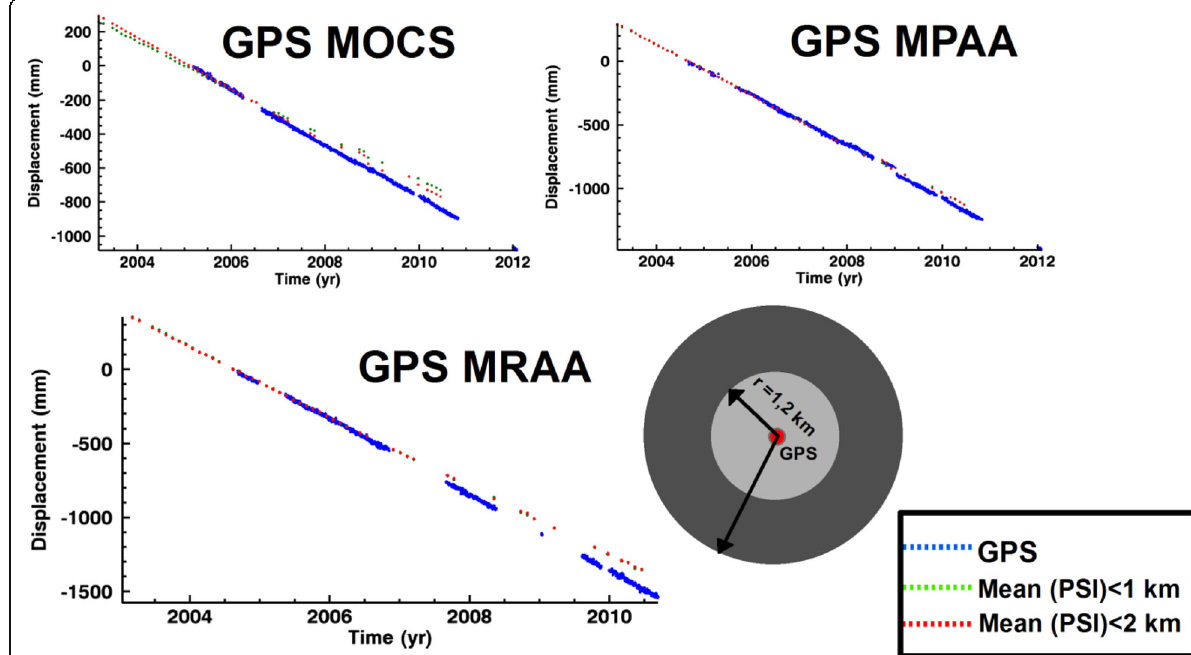
Fig. 11 Comparison of LOS GPS and average of subsets from PSI method